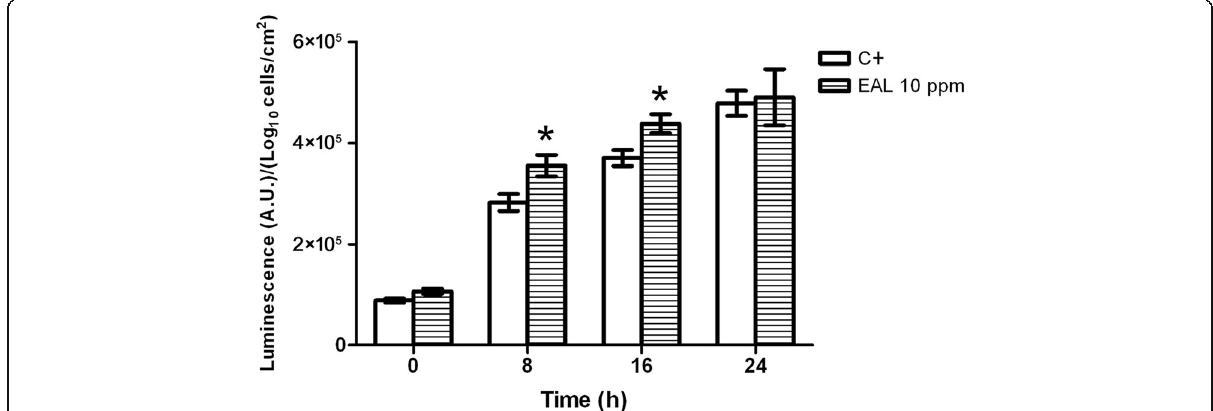
Fig. 9 Relative luminescence emitted by Vibrio harveyi in absence (positive control) and in presence of 10 ppm of E. acoroides leaf extract for 24 h. The relative luminescence has been calculated by normalizing luminescence by the number of adhered cells. Stars indicate statistically significant differences (Tukey ’ s HSD, p ≤ 0.05) between the means of three independent replicates. (C+= Positive control; EAL = Enhalus acoroides